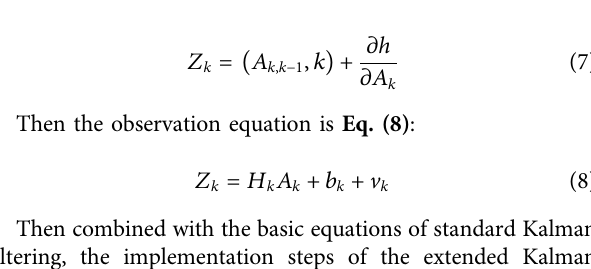
FIGURE 2 | Kalman fi lter structure